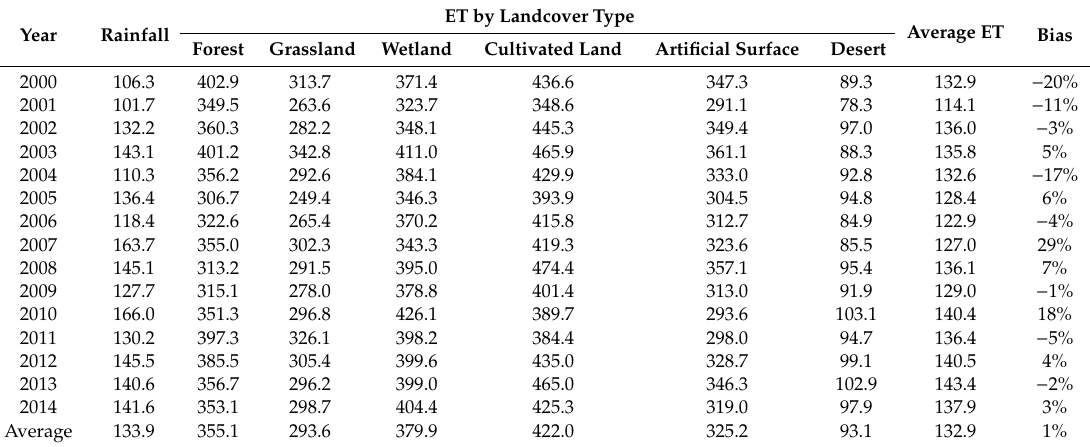
Table 2. Annual rainfall and estimated evapotranspiration (ET) by landcover type from 2000 to 2014 for the Heihe River Basin (in